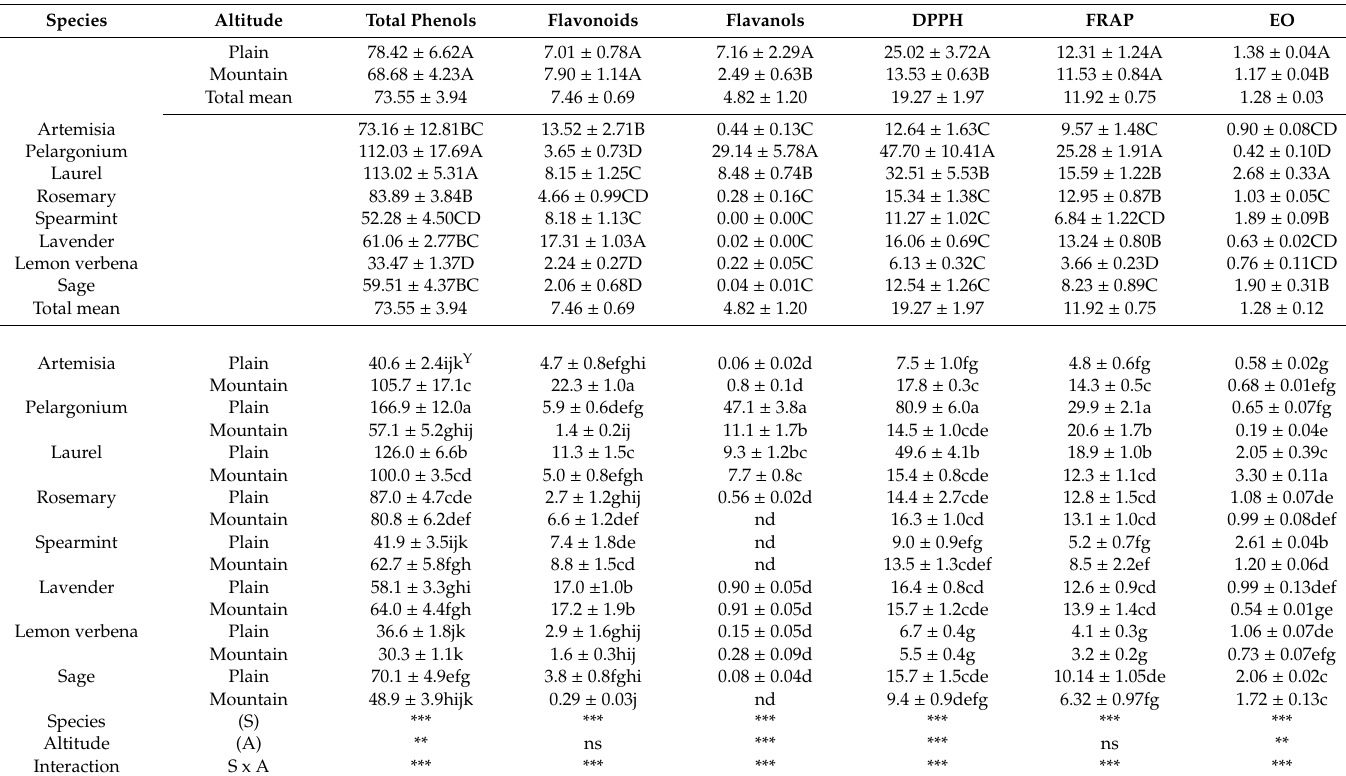
Table 2. E ff ects of altitude (mountain vs. plain) on the content of total phenols ( µ mol GAE g − 1 fw), total flavonoids (mg rutin g − 1 fw), total flavanols (mg catechin g − 1 fw), antioxidant and reducing activity (DPPH, FRAP, mg trolox g − 1 fw), and essential oil (EO) yield (%) in selected medicinal plant